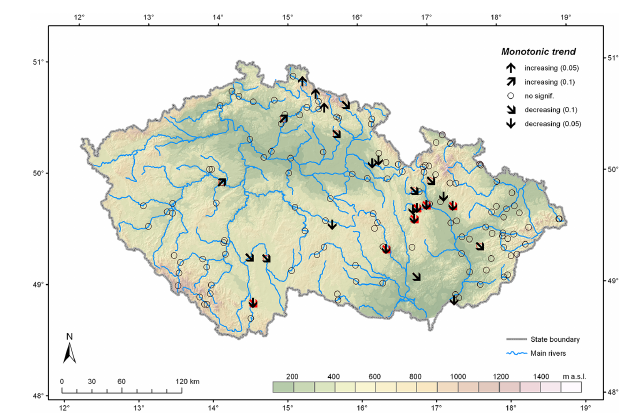
Figure 1. Spatial distribution of trends in summer (April– November) 7-day low flows ( Q min S ) in Czechia during the pe- riod 1961–2005 (black symbols – ABBS–MK test, red symbols – BHMLLESS–MK